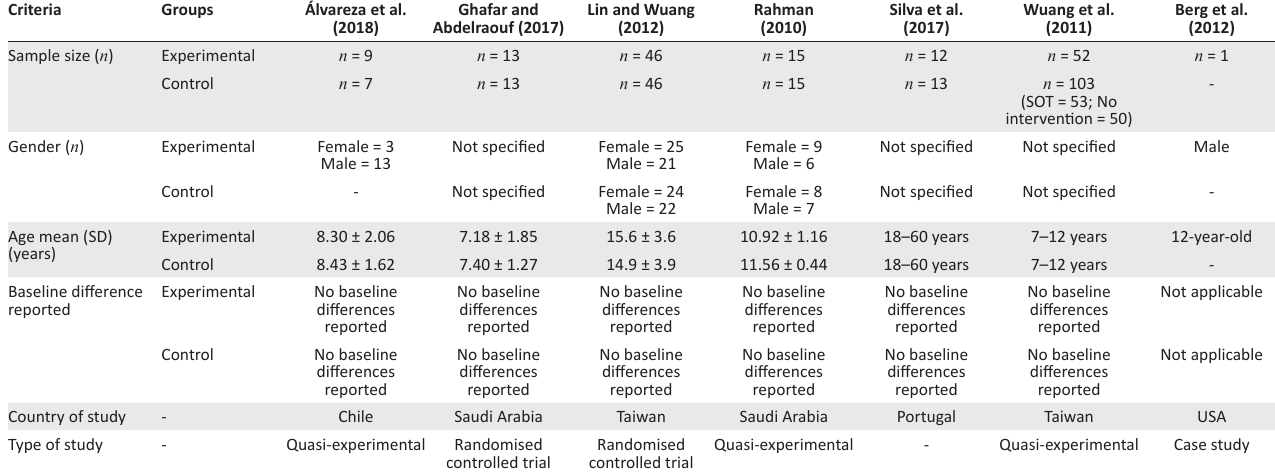
TABLE 2 : Study sample description. Criteria